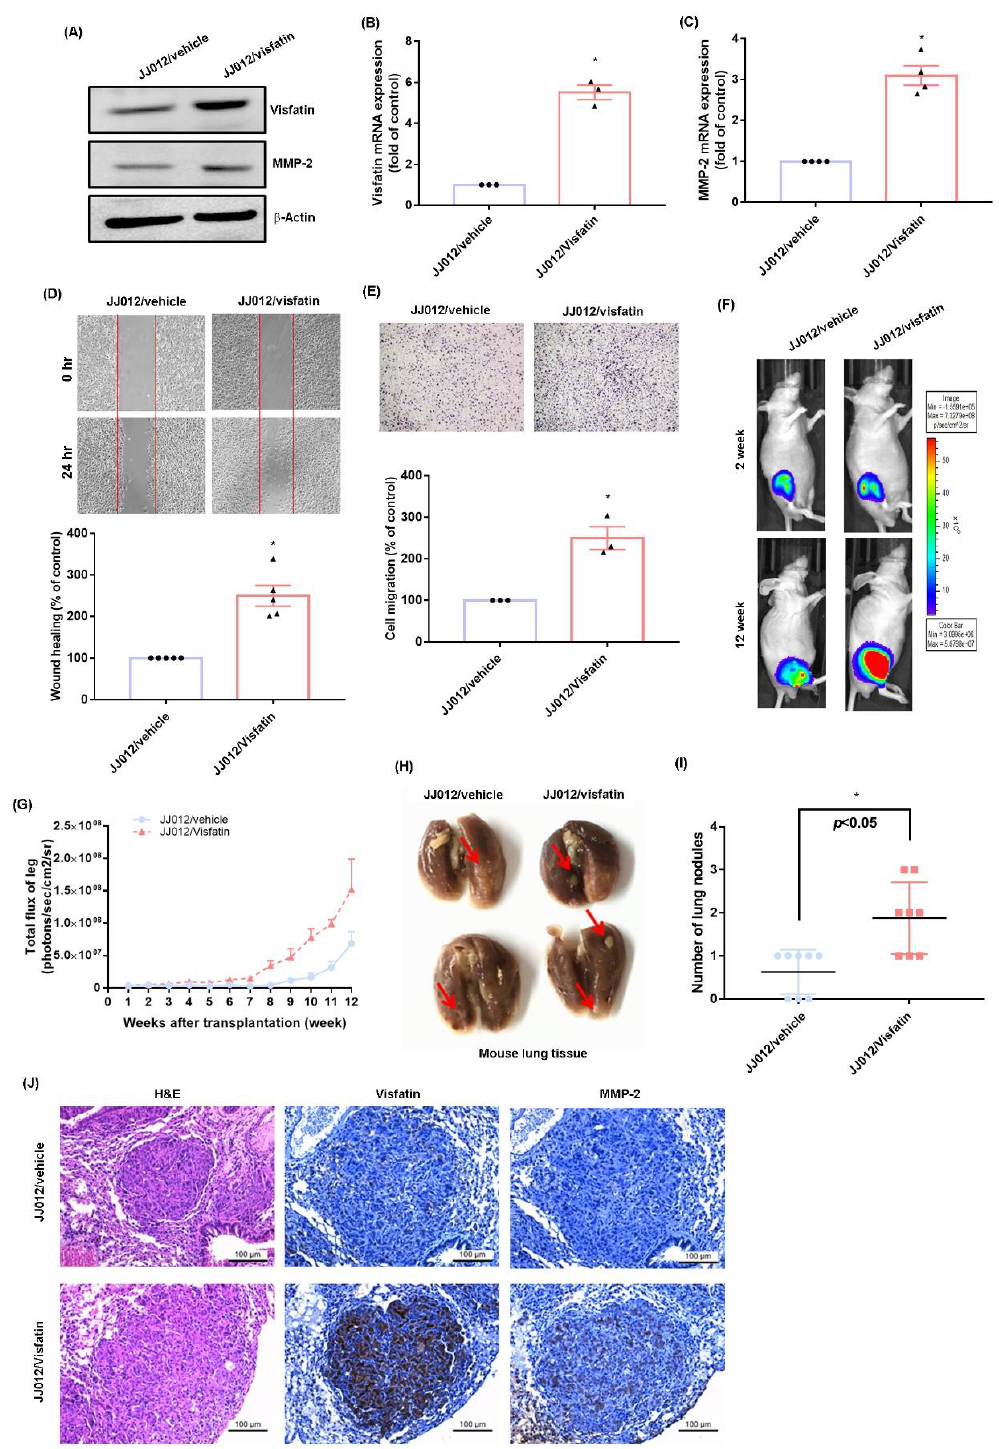
Figure 6. Visfatin promotes chondrosarcoma metastasis to lungs in vivo. ( A – E ) MMP-2 levels and migratory ability of JJ012/vehicle and JJ012/visfatin cells were examined by qPCR, Western blot, and Transwell. ( F , G ) The mice were injected with JJ012/vehicle or JJ012/visfatin cells. Lung metastasis was monitored by bioluminescence imaging at the indicated time intervals, then quantified by photon images. ( H , I ) After 12 weeks, the mice were humanely sacrificed and the lung tissue was excised, photographed, and quantified. ( J ) Levels of visfatin and MMP-2 expression in lung tumors were subjected